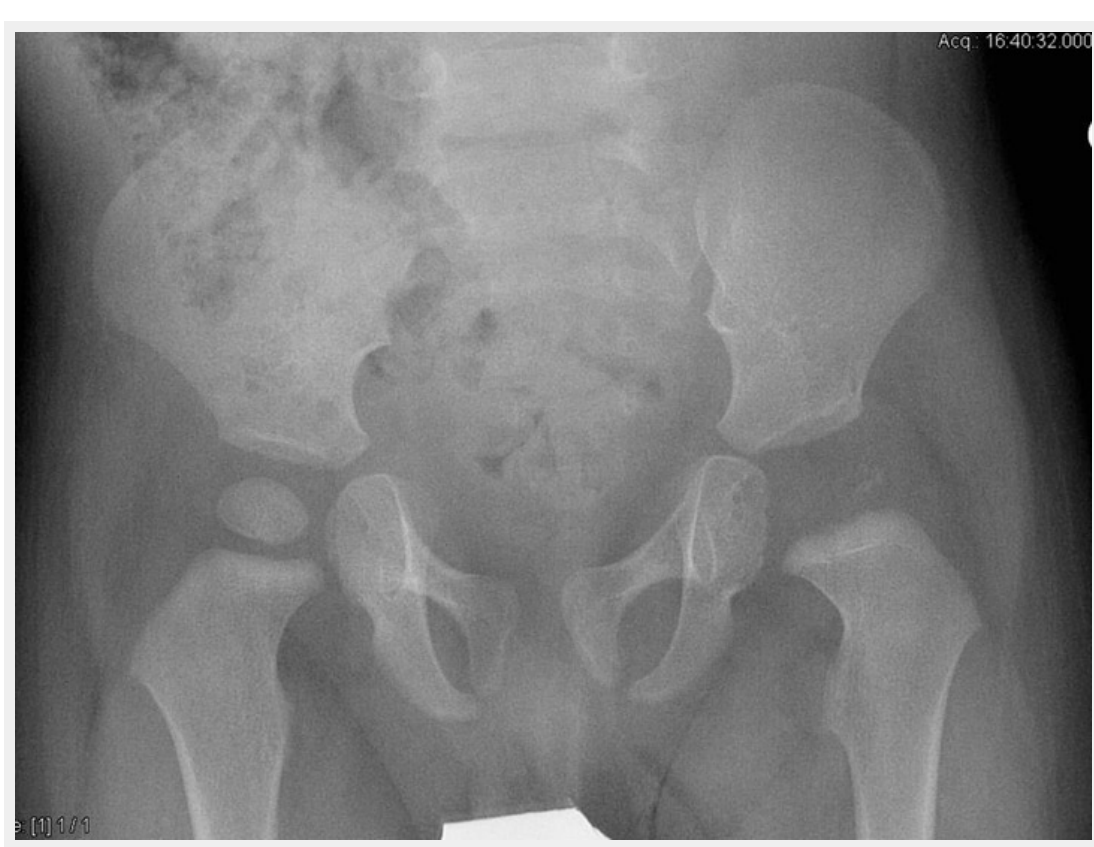
Figure 1 An 8-month-old boy sustained osteoarthritis of the left hip due to Streptococcus pneumoniae. Six months after the infection, the epiphyis had completely disappeared, confirming that children with osteoarticular infection due to S. pyogenes are more likely to have joint involvement, spread of infection into the epiphysis, and thus subsequent disturbed epiphysial